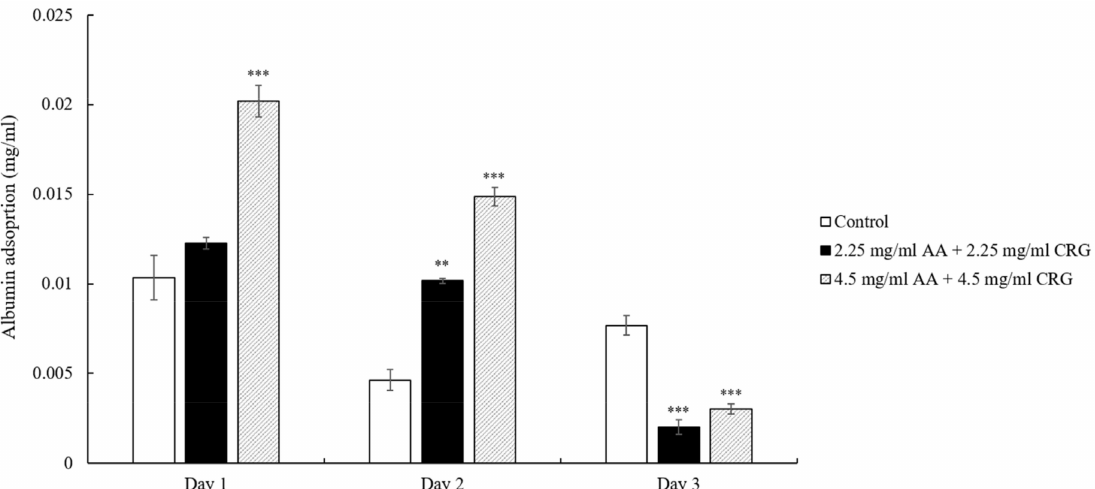
Figure 5. The concentration of albumin adsorption on the ortho-k lens when being immersed in artificial tear solution (control, white bars), 2.25 mg/mL (black bars) or 4.5 mg/mL (grey slashed bars) polysaccharides-containing artificial tear solution. * p < 0.05, ** p < 0.01, and *** p < 0.001 when